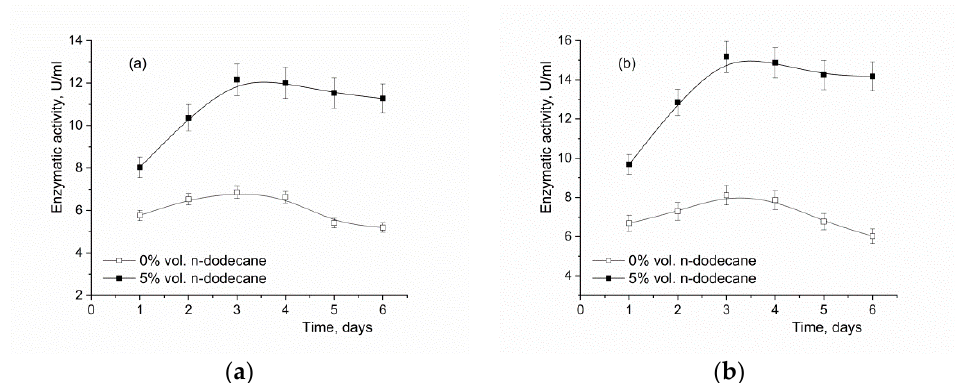
Figure 4. Variation of α -amylase activity during the fermentation cycle for uncontrolled pH-value ( a ) and adjusted pH-value at 6 ( b ). ( a ) and adjusted pH-value at 6 ( b